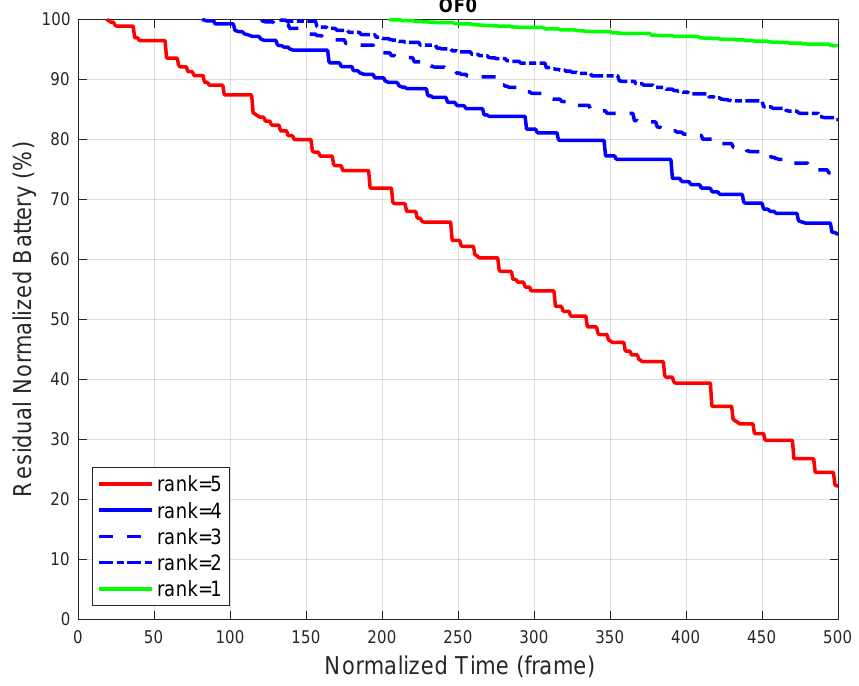
Figure 3. Residual normalized battery level time evolution of different groups of devices connected with RPL objective function zero